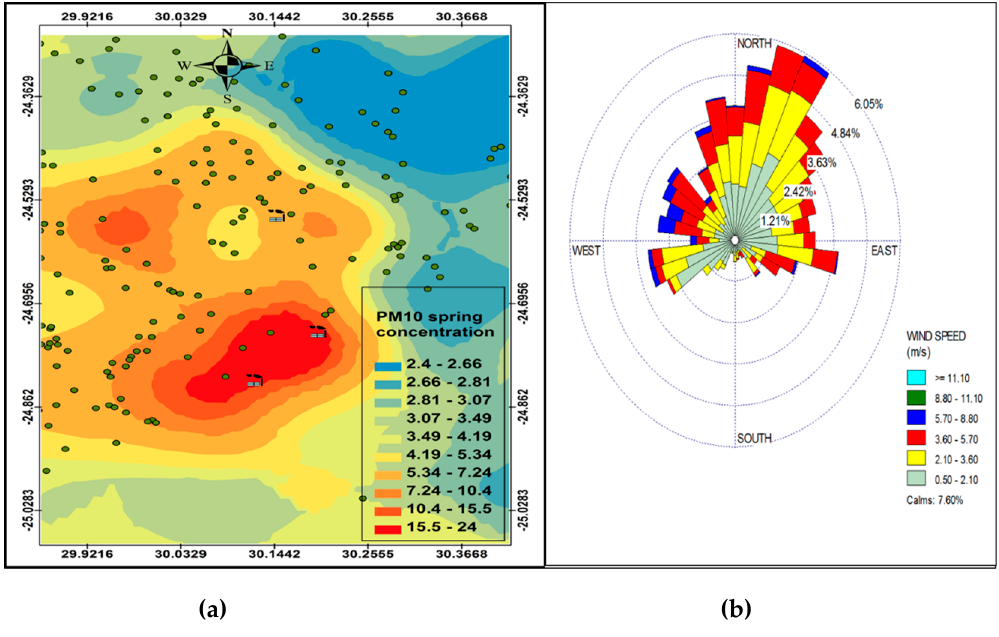
Figure 8. Spring variation in PM 10 ( µ g.cm − 3 ) ambient concentration ( a ) and wind roses ( b ).